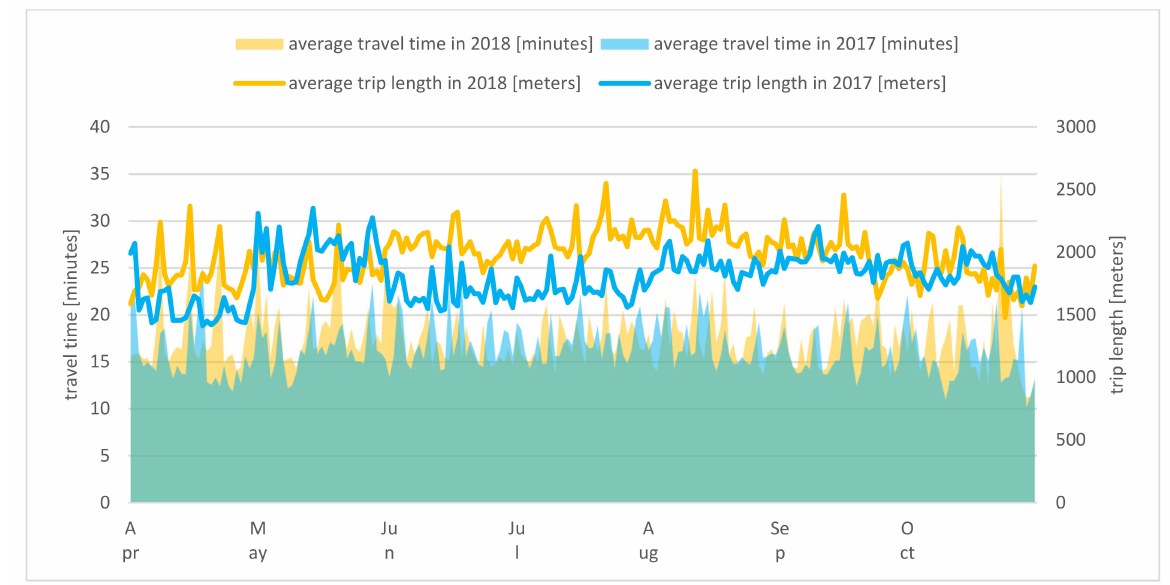
Figure 9. Differentiation of average length and duration of ŁPB trips in Łod´z in 2017 and 2018. Source: own elaboration based on data from the Ł ó d´z City Hall.